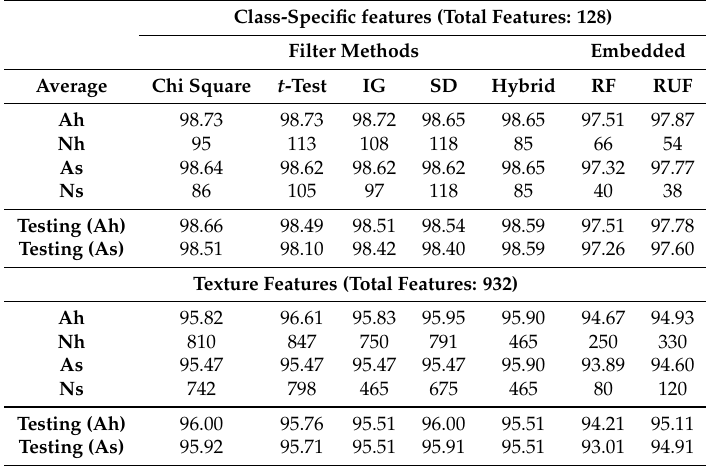
Table 6. Filter and hybrid methods: Experimental protocol 2. Class-Specific features (Total Features: